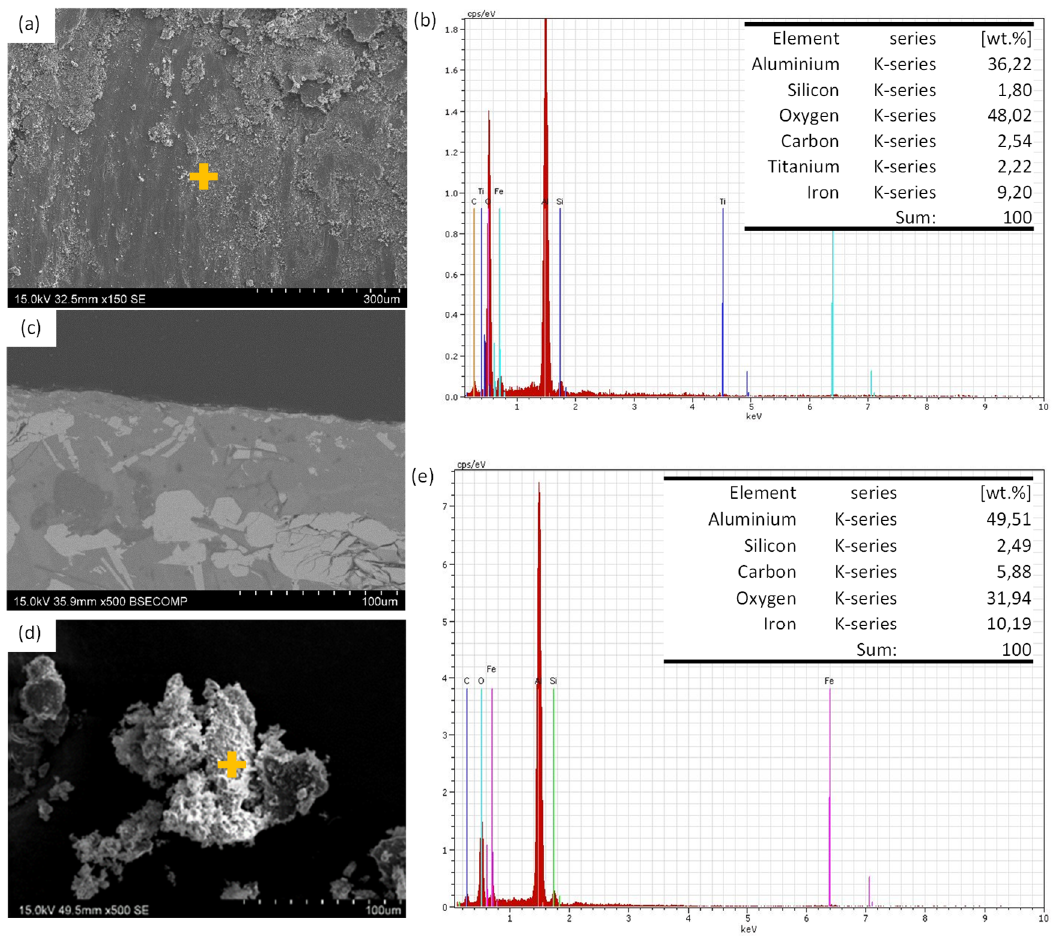
Figure 7. SEM micrographs of wear surfaces of LMD sample ( a ) wear surface; ( b ) EDS analysis made on surface shown in ( a ); ( c ) wear mark cross section; ( d ) wear debris; ( e ) EDS analysis made on debris shown in ( d ).